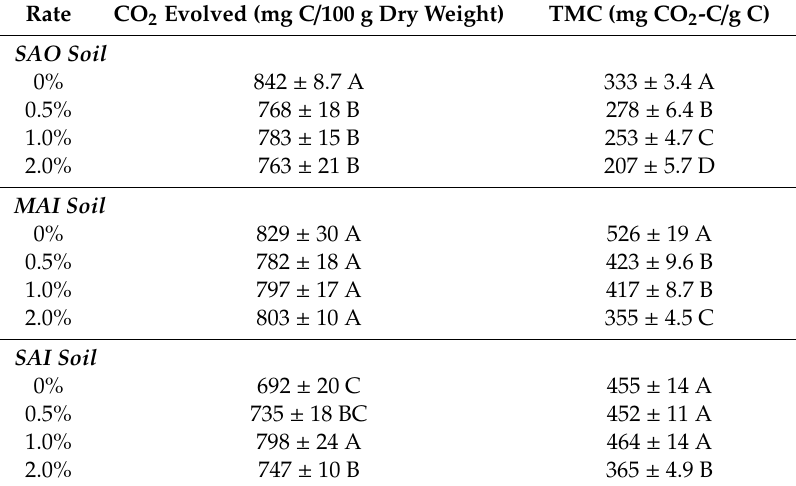
Table 2. CO 2 -C evolved (mg C / 100 g dry weight) and total mineralization coe ffi cient (TMC) for control and amended soils after the incubation experiment 1 .